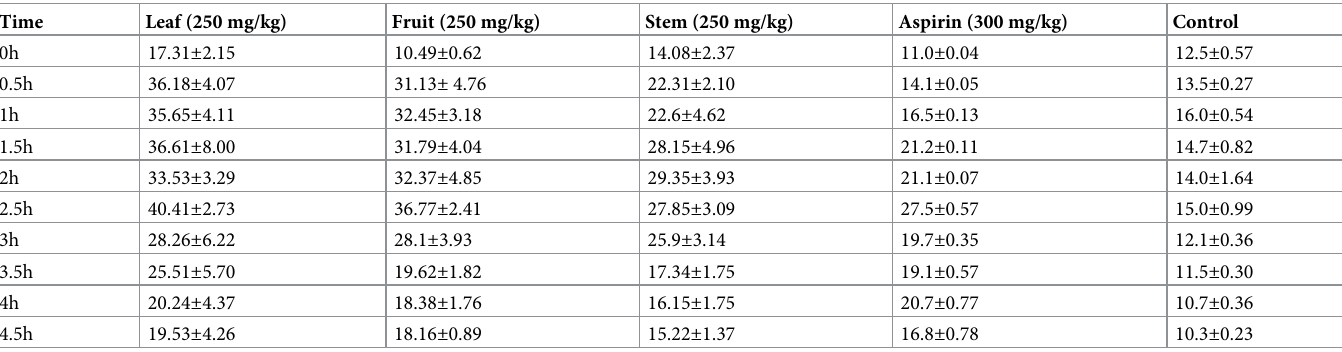
Table 4. The Hot plate technique was used to test the analgesic efficacy of a methanolic extract of E . spinosa leaf, fruit, and stem at a concentration of 250 mg/kg. Time Leaf (250